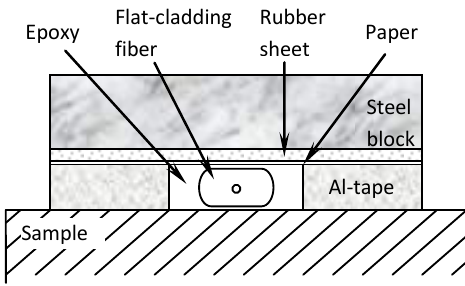
Figure 2. Schematic cross-section diagram of the bonding